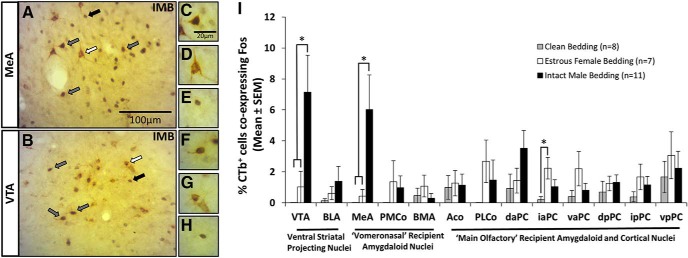
A subset of retrogradely labeled neurons in the MeA and VTA in female mice given a prior injection of CTb in the mOT coexpressed Fos in response to opposite-sex (male) volatile odors from soiled bedding (IMB). A, B, Representative photomicrographs depicting back-labeled CTb+ (brown) and Fos+ (black) neurons in the MeA (A) and the VTA (B). White arrows point to neurons positive for CTb; black arrows point to neurons positive for Fos; gray arrows point to neurons positive for both CTb and Fos (CTb+/Fos+). C–H, High-magnification (100×) photomicrographs depicting colabeled (CTb+/Fos+) neurons identified by gray arrows in the MeA (C) and VTA (F), neurons positive for CTb only identified by white arrows in the MeA (D) and VTA (G), and neurons positive for Fos only identified by black arrows in the MeA (E) and VTA (H). I, Effect of volatiles emitted from soiled bedding on the expression of Fos in various forebrain neurons of estrous female mice that were retrogradely labeled by a prior injection of CTb into the mOT. The mean percentage (±SEM) of CTb-labeled (mOT-projecting) cells that coexpressed Fos in response to volatiles from clean bedding, estrous female soiled bedding, or testes-intact male soiled bedding is shown in 13 forebrain regions where Fos/CTb colocalization was observed. *p ≤ 0.05 (SNK post hoc tests following a significant overall ANOVA). In the legend, n refers to the number of subject mice in each group. See the legend of Figure 3 for definitions of brain region acronyms.